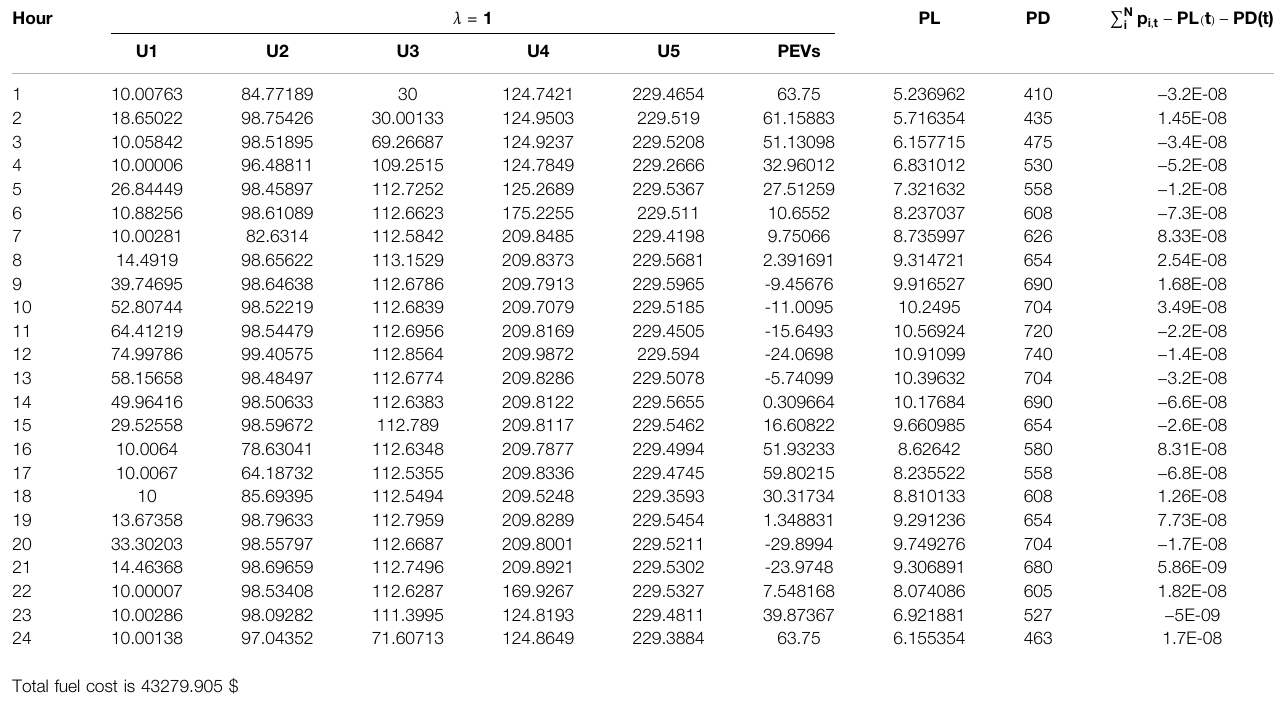
TABLE 13 | The optimal solution information for Case V : the 5 units with orderly PEVs. Hour